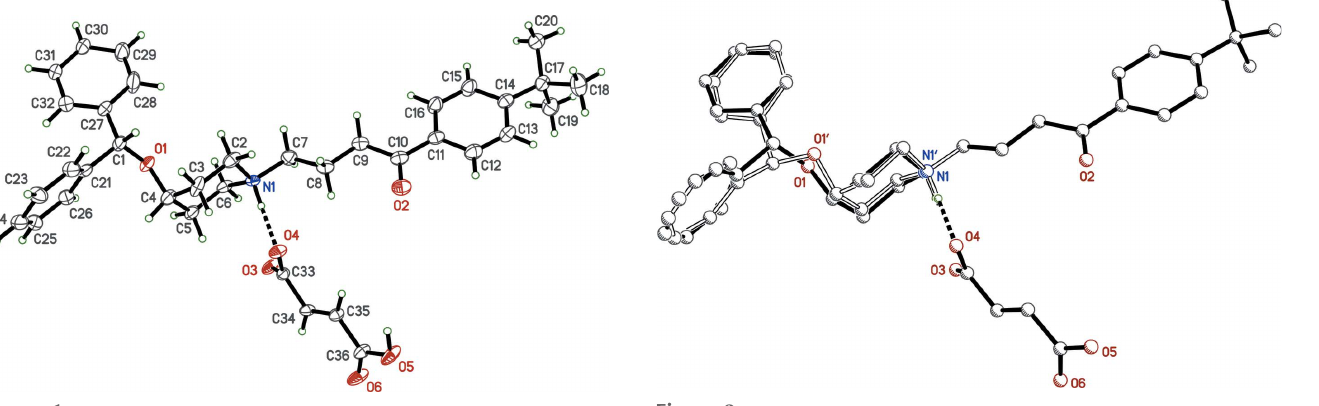
Figure 1 An ellipsoid plot (50% probability) of I . The N—H (cid:2)(cid:2)(cid:2) O hydrogen bond is shown as a dashed line. The minor component of disorder is omitted to enhance clarity.